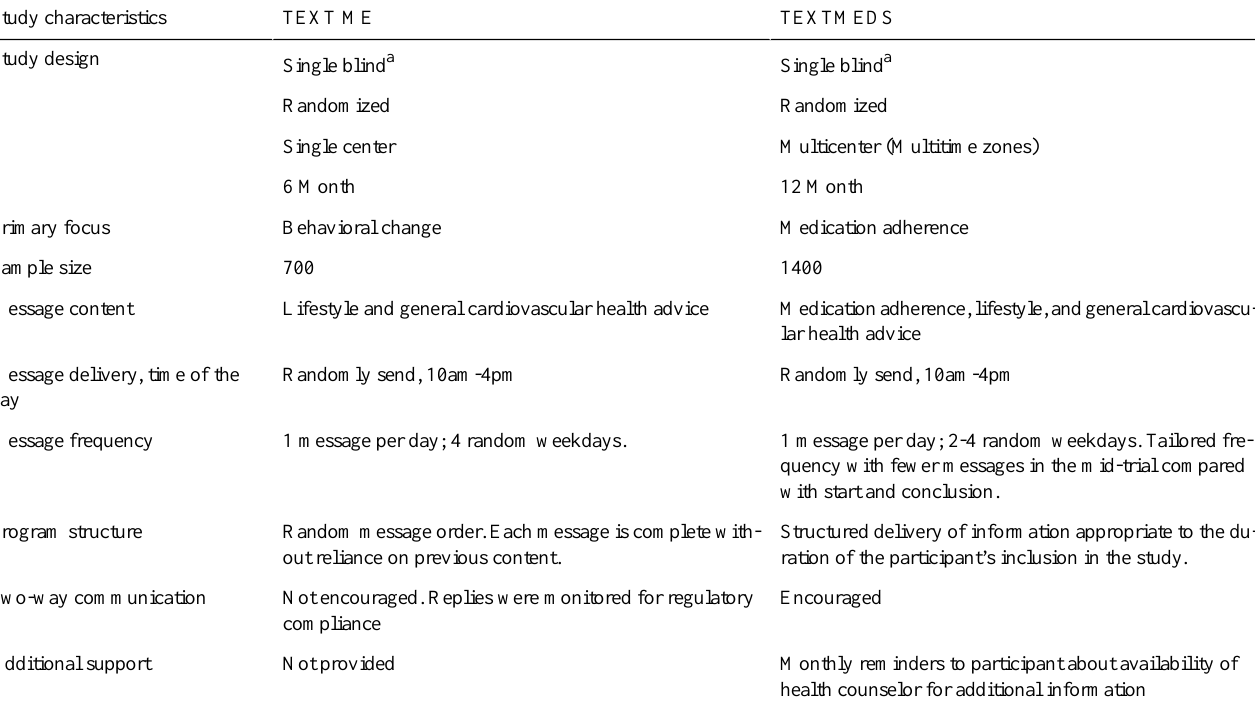
Table 1. Overview of TEXT ME and TEXTMEDS trials and intervention